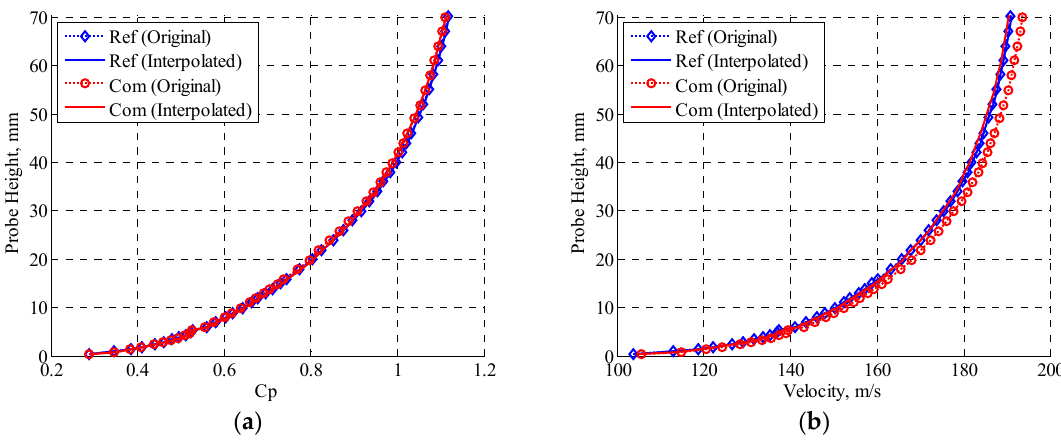
Figure 10. Comparison of profiles for smooth wall cases at two different flights (where ‘Ref’ denotes